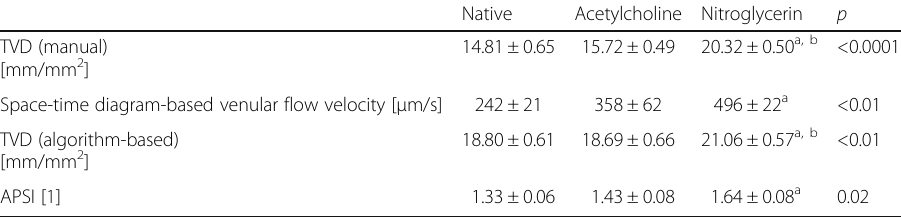
acetylcholine and nitroglycerin, as measured using manual video analysis and algorithm-based video